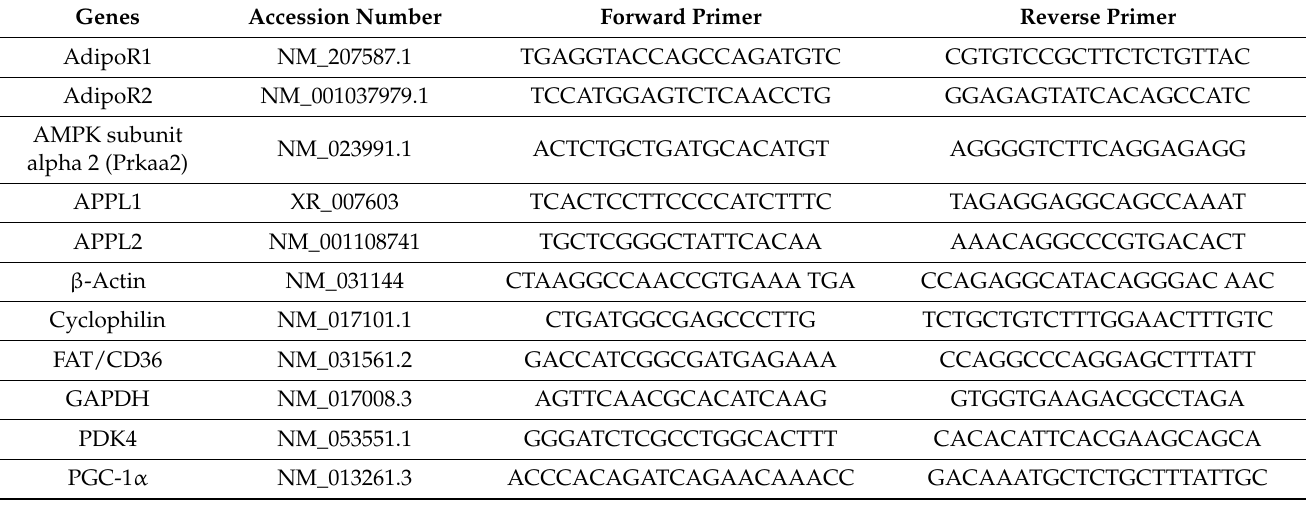
Table 4. Oligonucleotide PCR primers—Skeletal